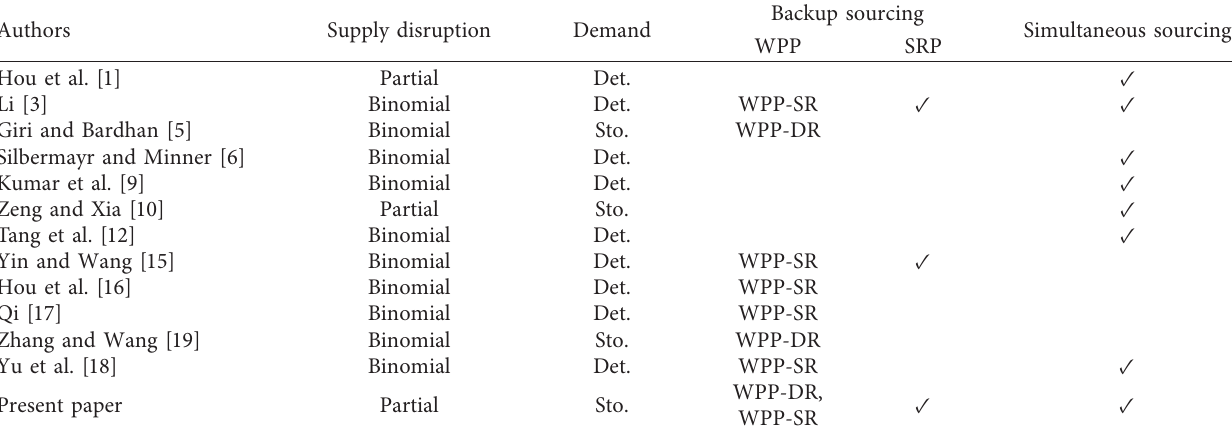
Table 1: Literature reviews of backup (simultaneous) sourcing models under supply